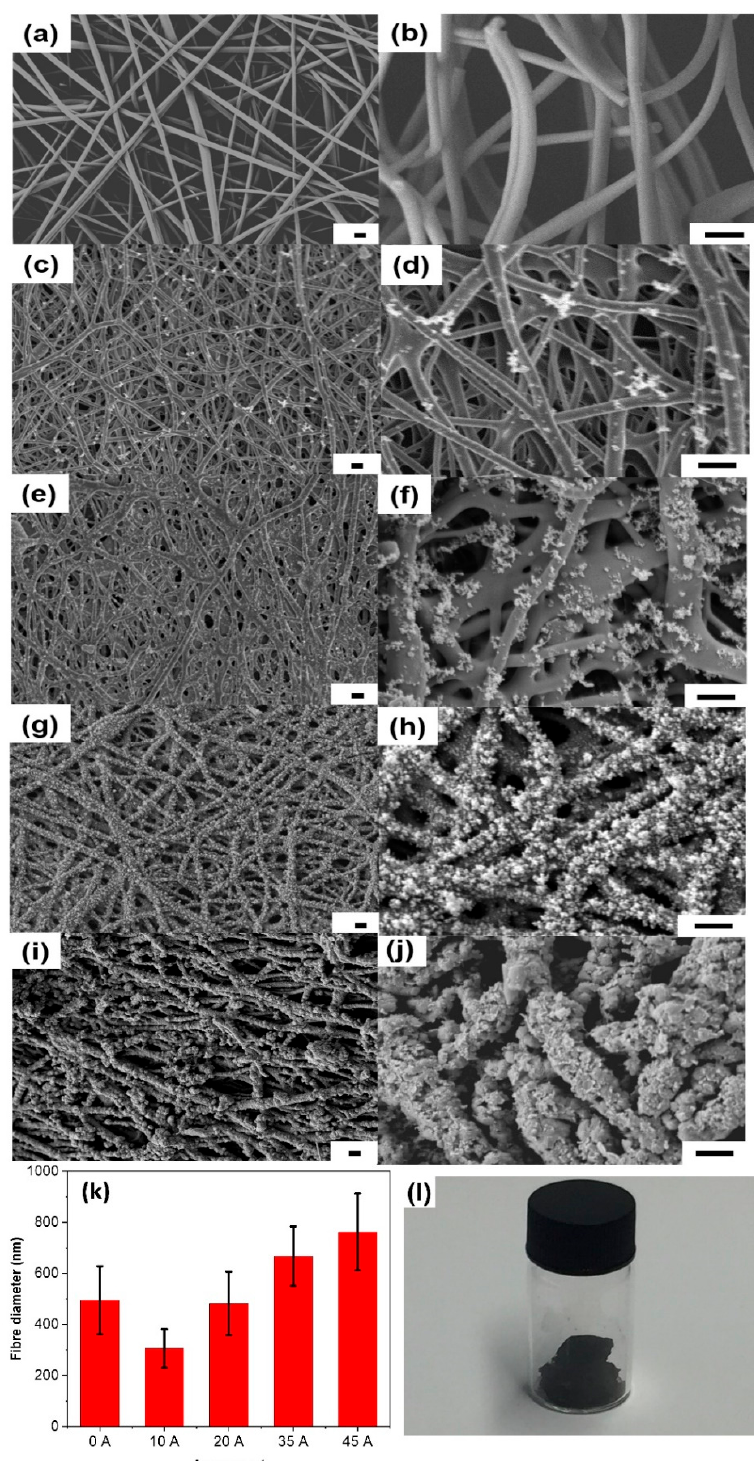
Figure 2. Low and high magnification SEM images of the carbon fibres treated with different levels of arc current: ( a , b ) 0 A (starting material; untreated lignin fibres), ( c , d ) 10 A, ( e , f ) 20 A, ( g , h ) 35 A, and ( i , j ) 45 A. All scale bars are 1 μ m. ( k ) Average thicknesses of the fibres prepared with different levels of arc current. ( l ) Sample collected after arc discharge at 45 A.